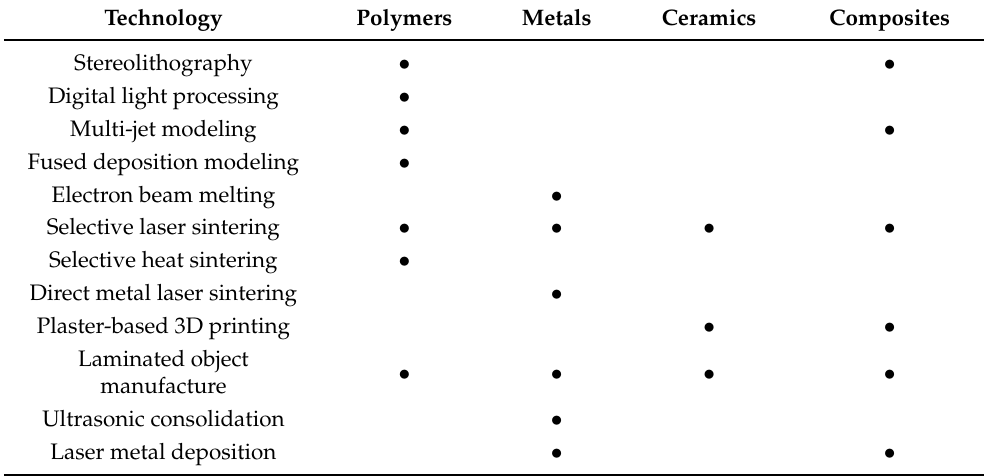
Table 1. Materials for additive manufacturing and related technological processes.